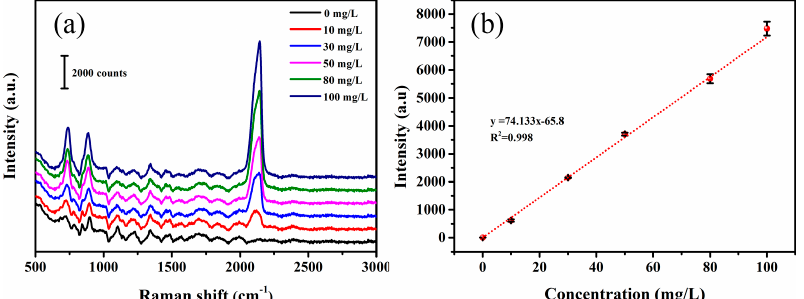
Figure 5. The SERS detection of NaSCN in the milk (repeated three times). ( a ) SERS spectra of the milk mixed with different concentrations of NaSCN. ( b ) The relation curve between the intensity of SERS at 2126 cm − 1 and the concentration of NaSCN.